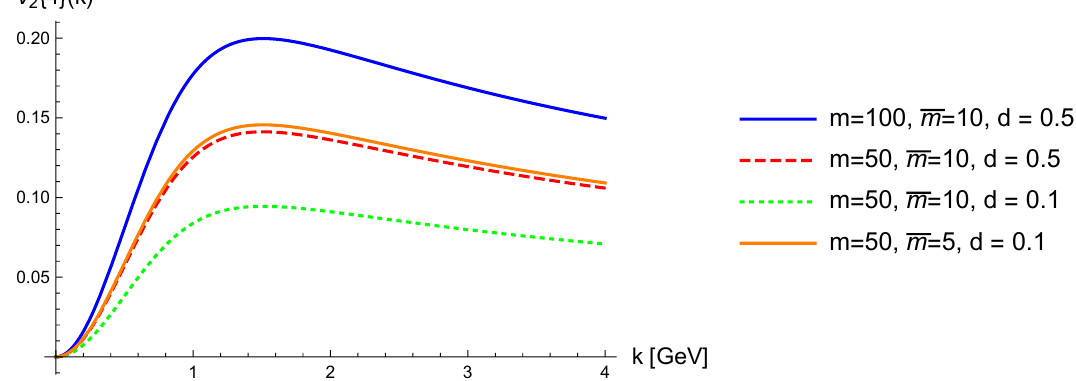
Figure 9 . Approximation (7.3) of the 4-th order cumulant v 4 average multiplicities m per source and values of the suppression factor d , obtained from intergrating out one dipole radiation